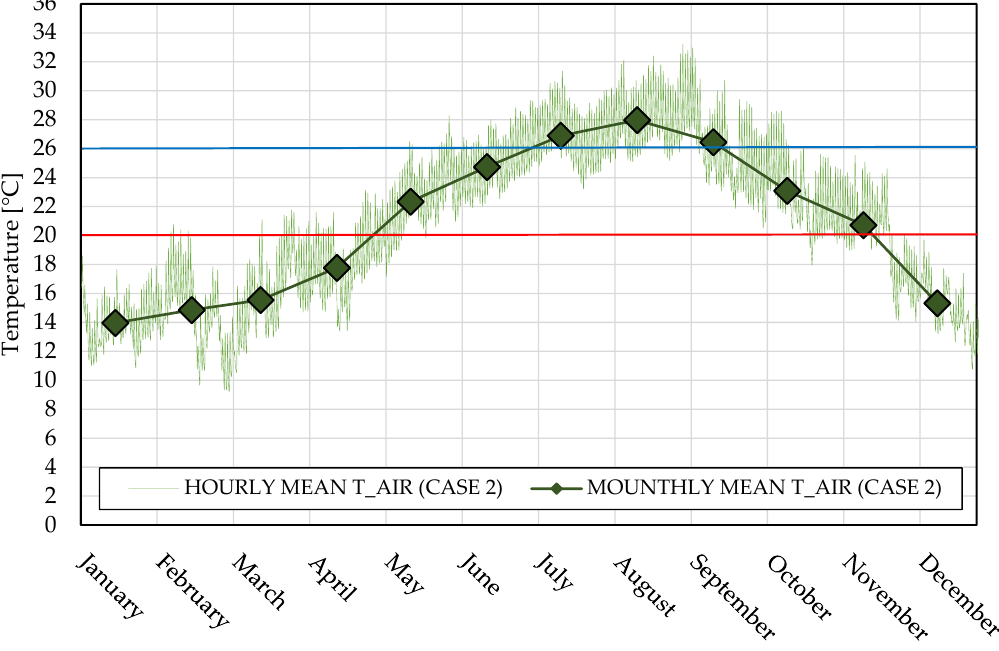
Figure 9. Hourly average and the monthly average of the indoor air temperature (CASE 2) with PCM23.